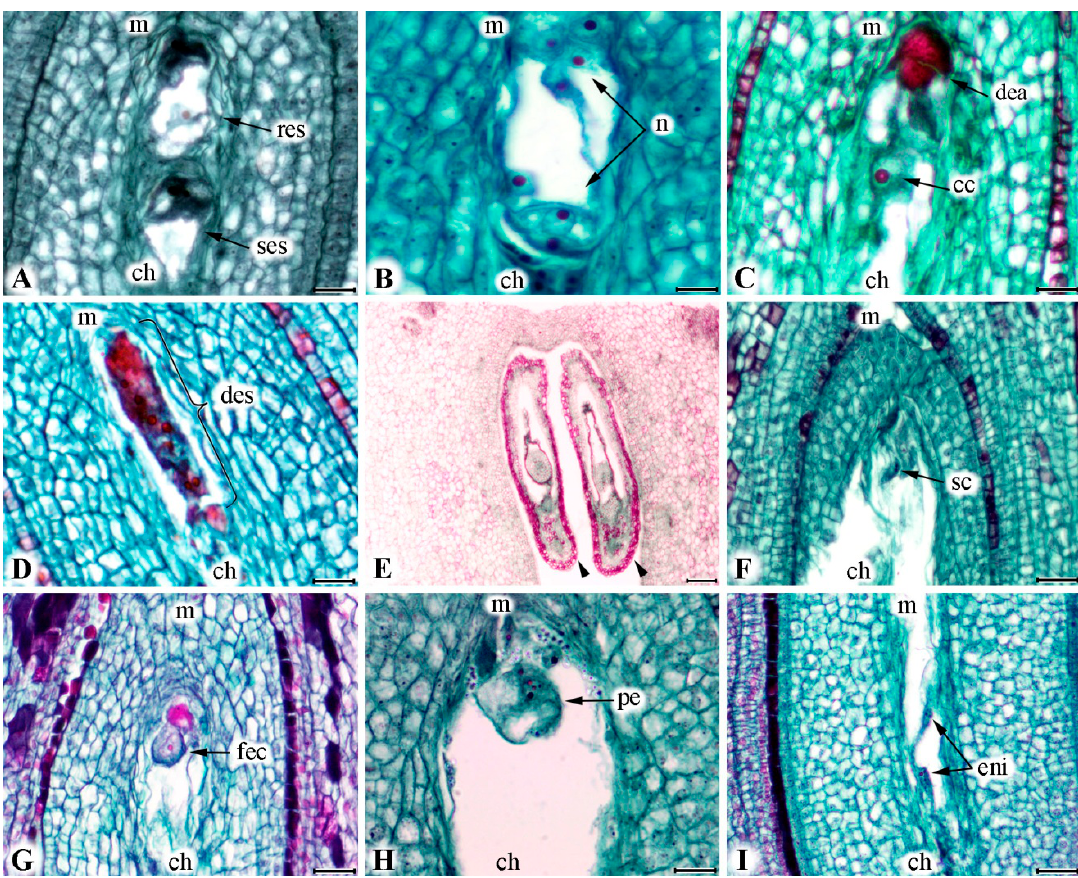
Figure 5. Development of embryo sac in pear cultivars ‘Ingeborg’ and ‘Celina’. ( A ) Regular embryo sac and supernumerary embryo sac—‘Ingeborg’. ( B ) Irregular number and spatial distribution of nuclei in embryo sac—‘Ingeborg’. ( C ) Degenerating of egg apparatus and central nuclei—‘Celina’. ( D ) Occurrence of degeneration of all elements of embryo sac—‘Ingeborg’. ( E ) Degeneration of ovules—‘Ingeborg’. ( F ) The sperm cells inside pollen tube—‘Celina’. ( G ) Fertilized egg cell—‘Ingeborg’. ( H ) Early embryogenesis—‘Celina’. ( I ) Endosperm nuclei—‘Ingeborg’. (m = micropylar pole; ch = chalazal pole; res = regular embryo sac; ses = supernumerary embryo sac; n = nuclei; dea = degenerated egg apparatus; cc = central nuclei; des = degenerated embryo sac; arrowheads = degenerated ovules; sc = sperm cells; fec = fertilized egg cell; pe = pro-embryo; eni = endosperm nuclei). Scale bars = 0.01 mm.